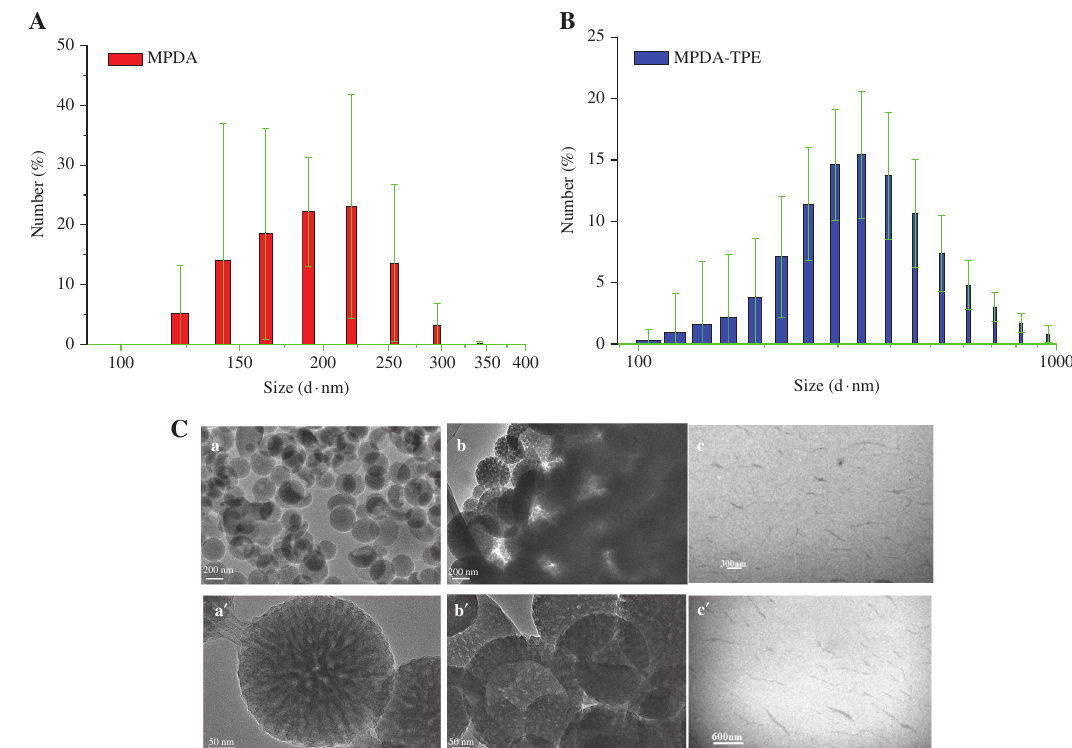
Figure 2: Characterization of physicochemical properties of the prepared CCNC and MPDA-TPE in vitro . DLS of (A) MPDA and (B) MPDA-TPE. (C) TEM of (a, a ′ ) MPDA, (b, b ′ ) MPDA-TPE, and (c, c ′ )